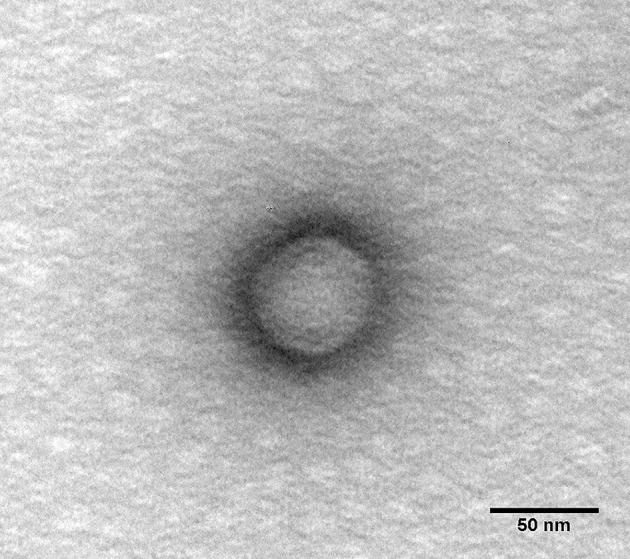
TEM micrograph of PAO1-D bacteriophage particle (scale bar 50 nm).